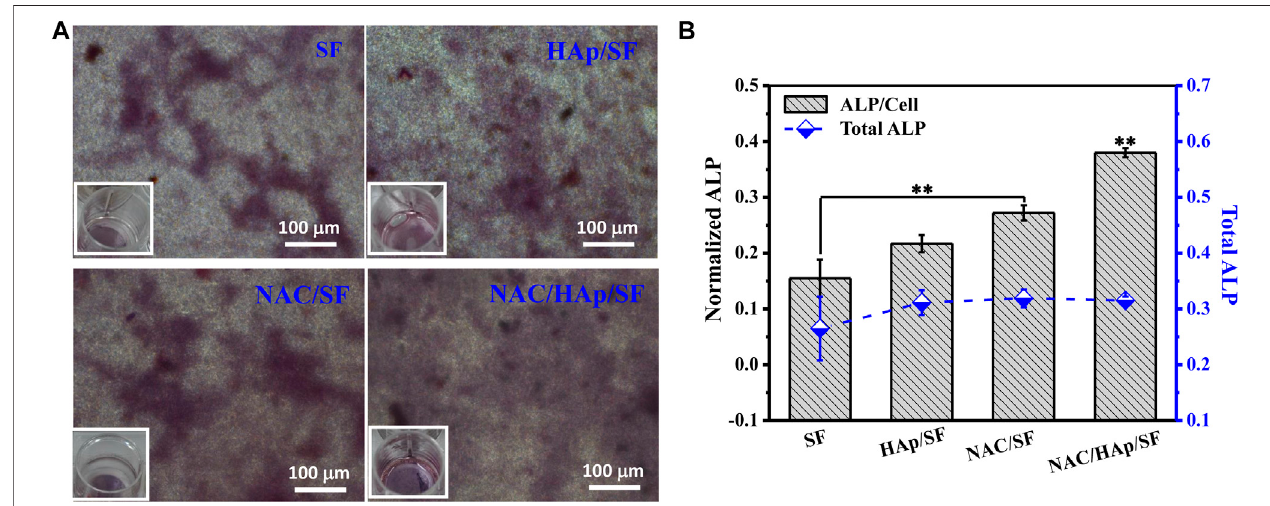
FIGURE 8 | ALP staining. (A) and quantitative detection of ALP. (B) after iPSC-MSC culture on different composite fi bers for 14 days, n (cid:1) 3.